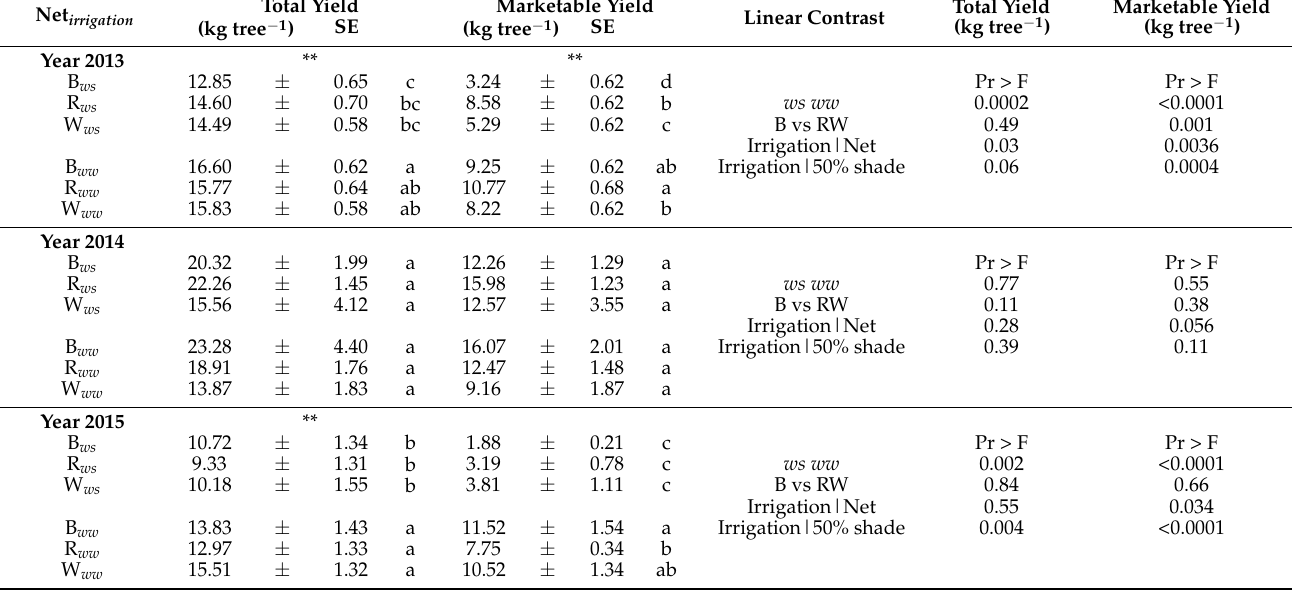
Table 6. Total yield and marketable yield for net irrigation treatments during the years 2013, 2014, and 2015. Means are followed by standard error. The interaction between treatments and crop load was not found to be significant. The effect of crop load alone was considered significant (**), thus, when ** occurs, each value is the LS means of an ANCOVA (mean of 4 trees). When no effects are detected, each value is the result of a simple ANOVA (mean of 4 trees). The presence of different letters indicates significant differences at p < 0.05. No letters indicate no significant differences. On the right side of the table, linear contrast F values for each year are shown; values below 0.05 are considered significant.